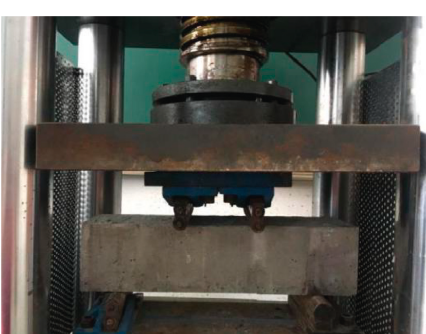
Figure 5: Flexural strength